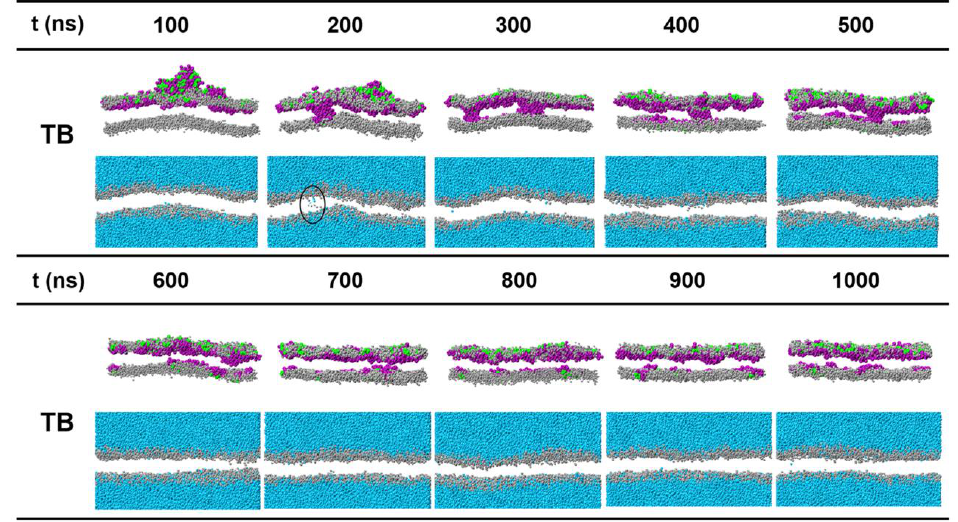
Figure 8. Time sequences of snapshots of planar bilayers treated with temporin B at a concentration of P/L = 7.3%. Lipid tails are not shown for clarity. In the second line, water and lipid heads are shown separately. As circled, a few water beads can pass through the channel.